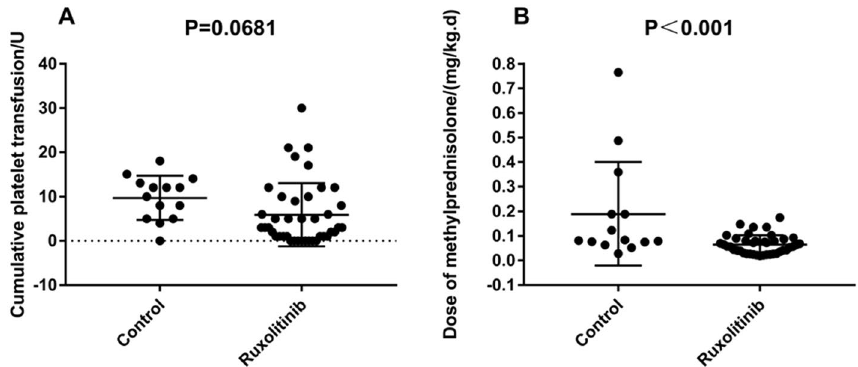
Figure 2. Comparison of the cumulative platelet transfusion ( A ) and the average dose of corticosteroids (converted into methylprednisolone) ( B ) within 100 days after transplantation between the control and ruxolitinib groups. (Graphpad prism 8.0.1 https:// www. graph pad. com/ scien tific- softw are/